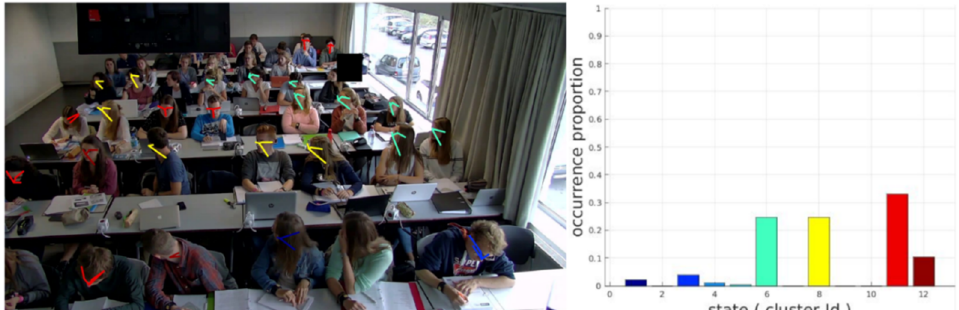
Figure 3. Example of the clustering approach applied to the keypoints of students’ heads. Students are allocated to different clusters depending on their eye-gaze direction (here in a face-to-face setting). Students allocated to the red cluster tend to look to the front. The yellow, light green and dark blue clusters group students that are looking to the side or backwards. The feature spaces covered by each of these clusters only differ in a subtle and not necessarily meaningful way. As an example, the students allocated to the yellow cluster seem to have a larger nose-to-chest distance. The blue cluster includes a student that is looking down. Results are less consistent for the dark red cluster that includes two front-row students that were wrongly detected. The graph in the top right corner shows Ψ s , the collective state distribution.